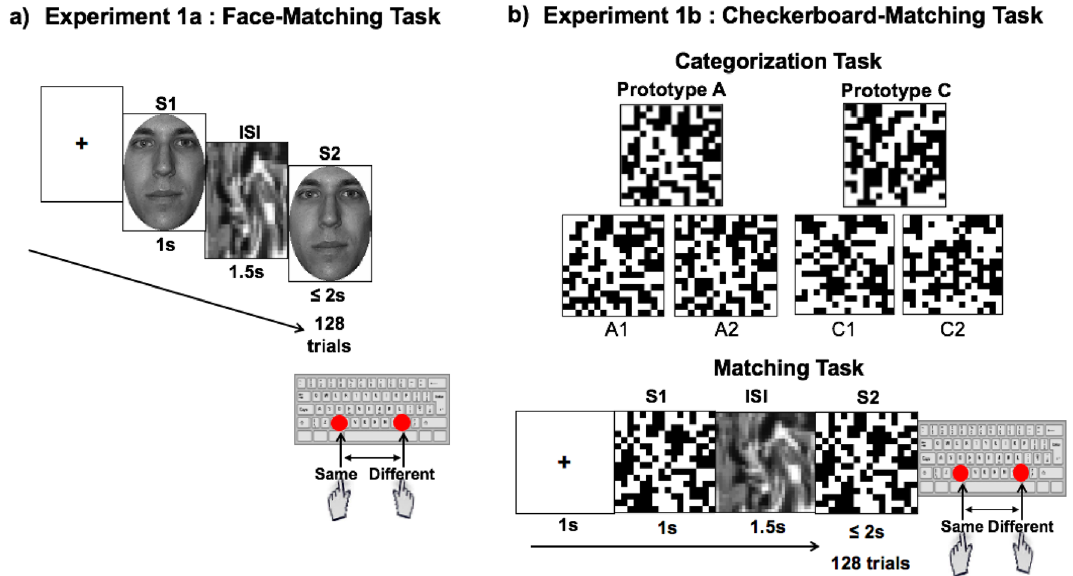
Figure 2. Panel ( a ) illustrates the behavioral task adopted in Experiment 1a. The original face images were selected from the Psychological Image Collection at Stirling open database, (http://pics.stir.ac.uk). Panel ( b ) illustrates the behavioral task adopted in Experiment 1b. The checkerboard exemplars were selected from Civile et al. 17 (Experiment